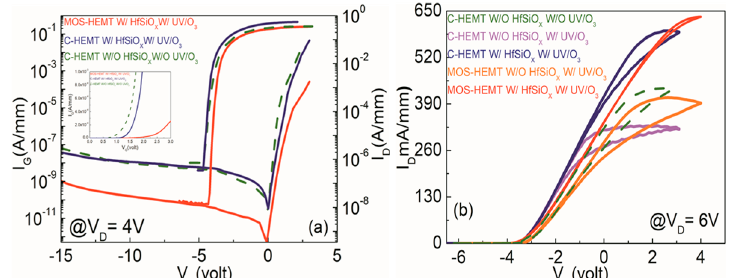
Figure 5. Comparison of ( a ) subthreshold (@ V D = 4V) and gate leakage (I G -V G ) characteristics of C- HEMT (before and after UV/O 3 treatment) and MOS-HEMT with HfSiO X passivation. ( b ) Hysteresis characteristics of (@ V D = 6V) C-HEMT (before and after UV/O 3 treatment) and MOS-HEMT with and without HfSiO X passivation.